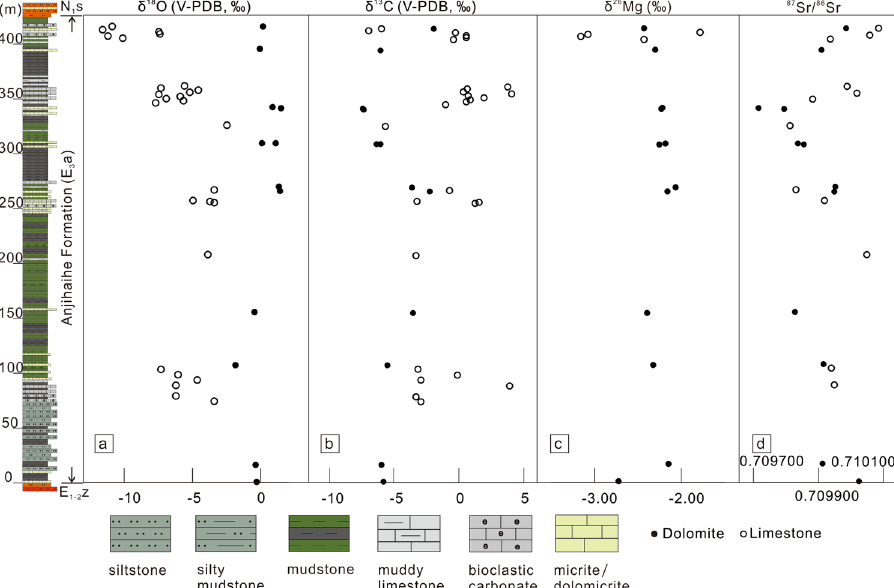
Figure 2. Lithostratigraphic profile of the Anjihaihe section and ( a ) oxygen, ( b ) carbon, ( c ) magnesium, and ( d ) strontium isotopic results of the Anjihaihe dolomite and limestone. The solid circles represent the dolomite samples and the open circles represent the limestone